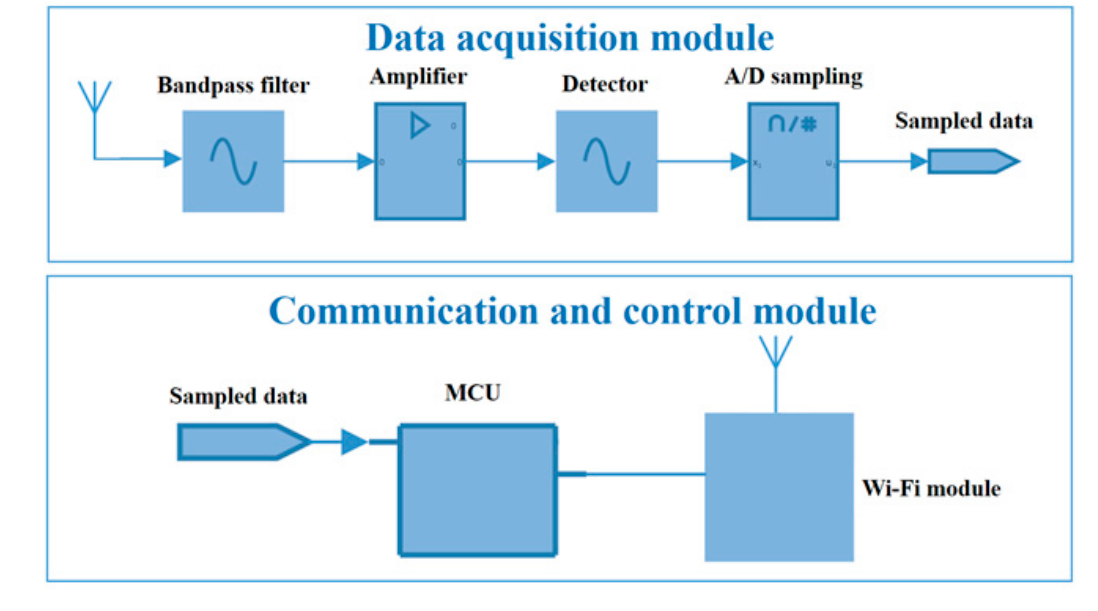
Figure 9. The diagram of wireless UHF sensor.